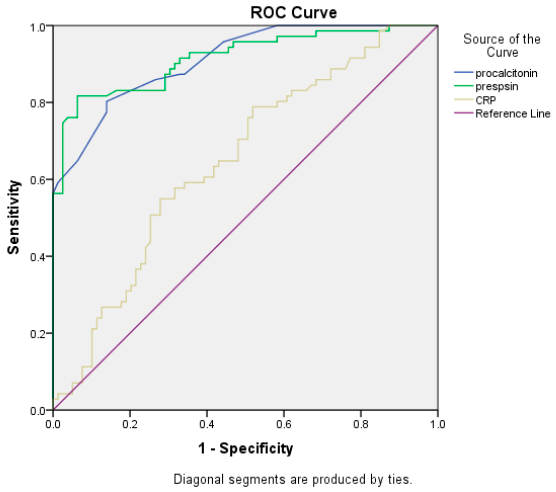
Figure 3. Comparisons of the three biomarkers’ ROC curves.